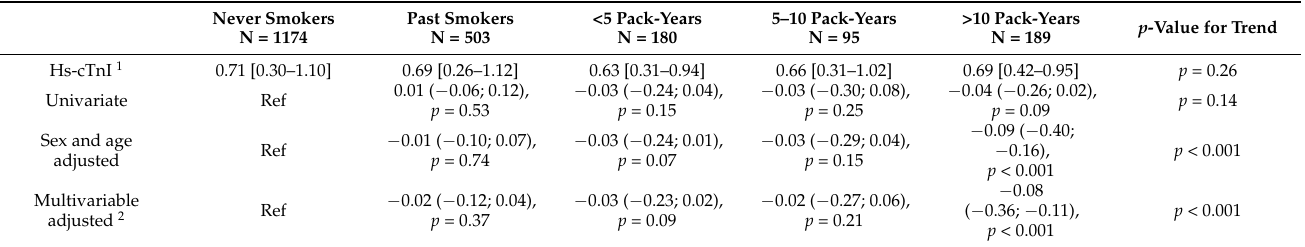
Table 3. Pack-years of smoking in relation to hs-cTnI.